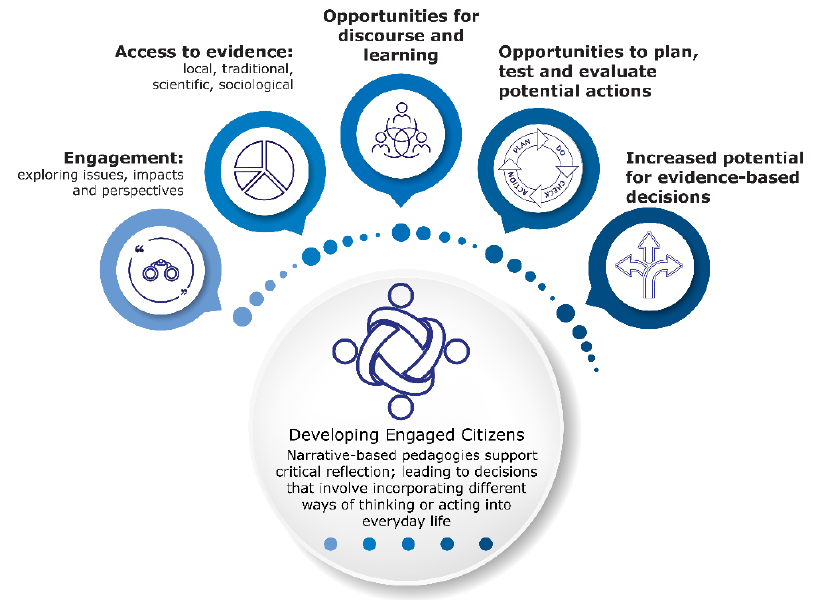
Figure 2. Use of narrative-based pedagogies to support evidence-based actions. Information adapted from Bay et al. [83].